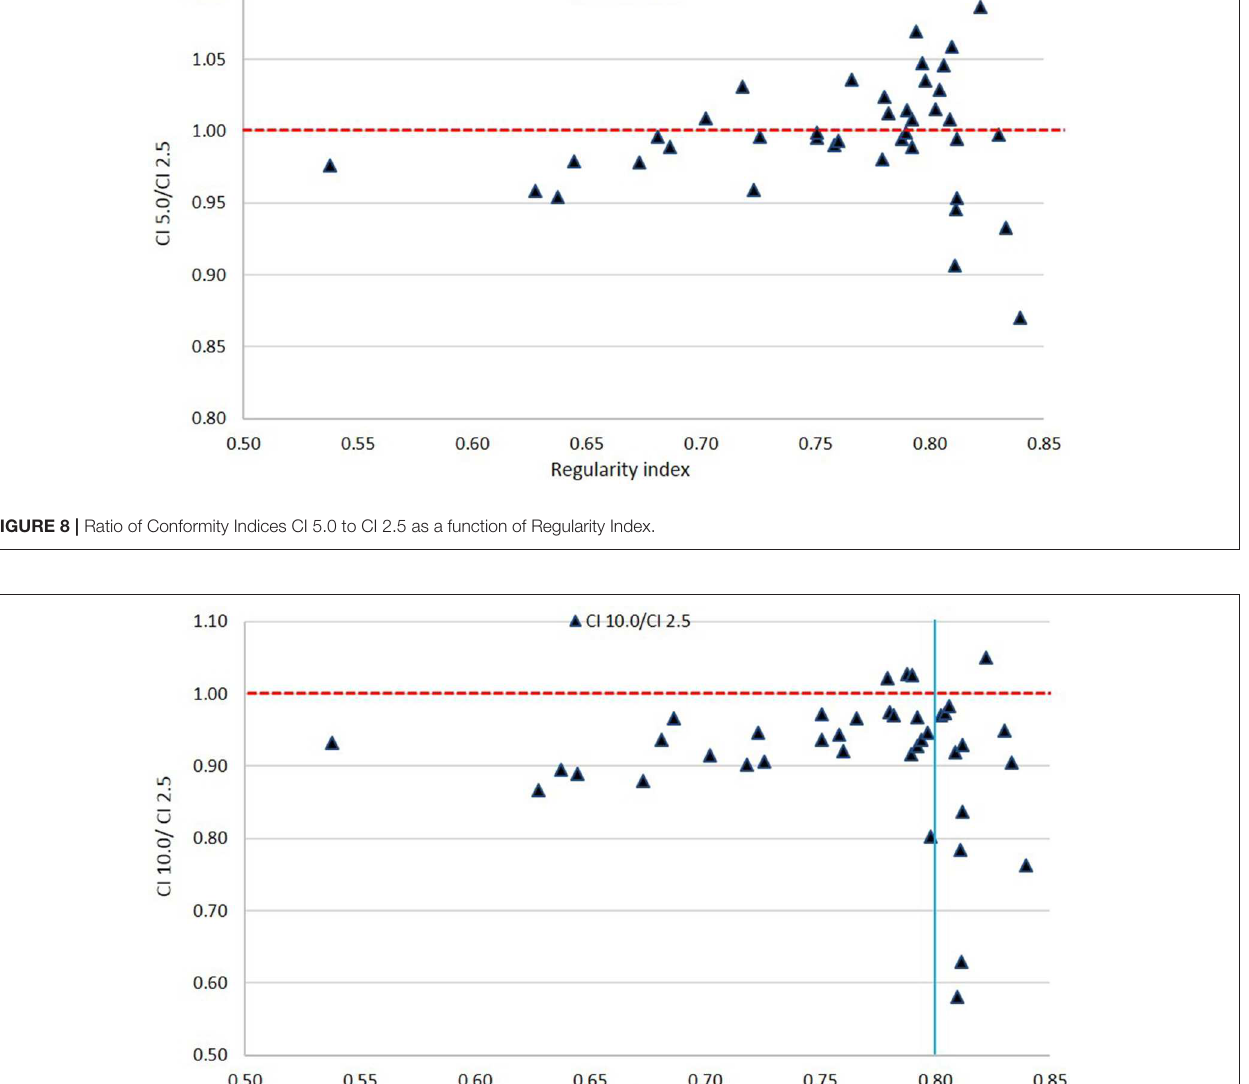
Frontiers in Oncology |